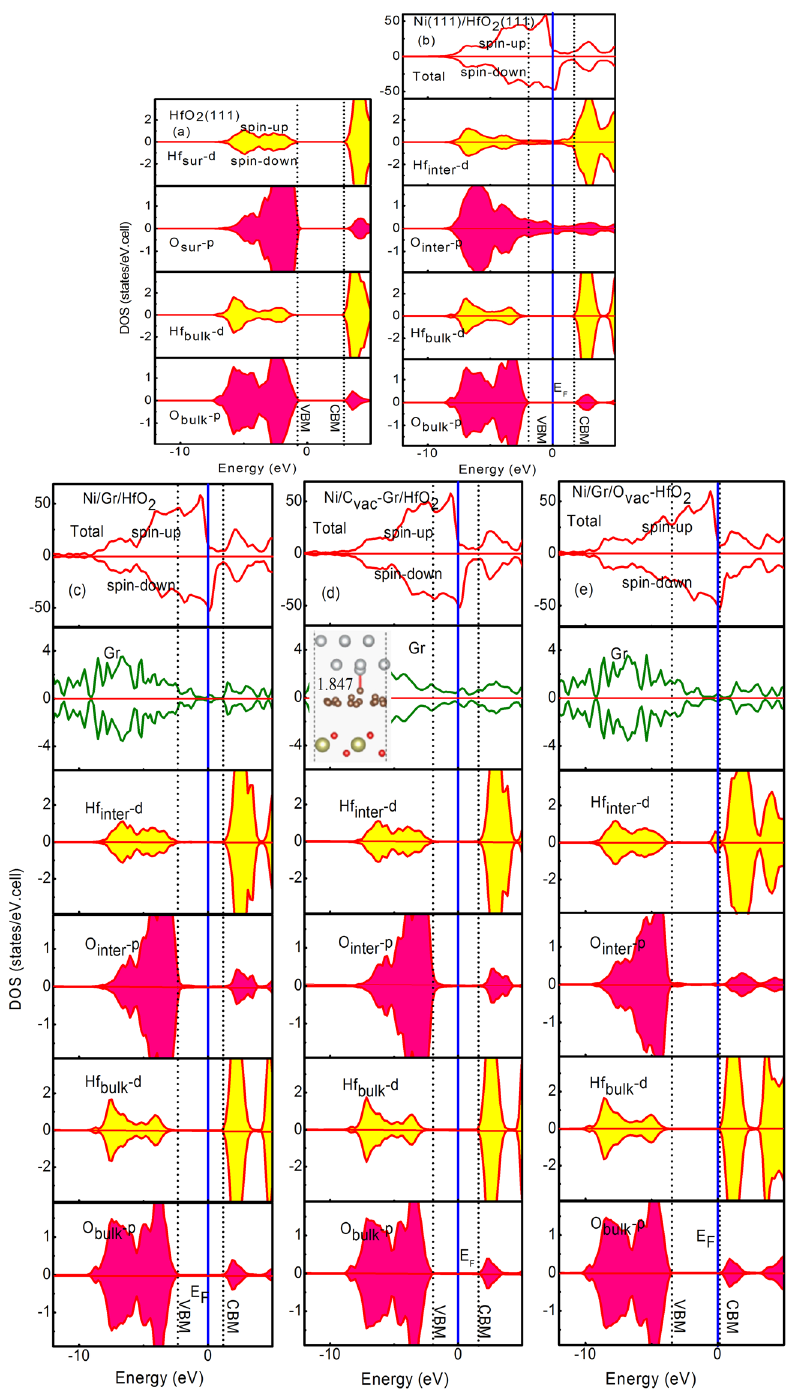
Figure 4. Total density of states (tDOS) and orbital-resolved partial density of states (PDOS) for ( a ) HfO 2 (111), ( b ) Ni(111)/HfO 2 (111), ( c ) Ni(111)/Gr/HfO 2 (111), ( d ) Ni(111)/C vac -Gr/HfO 2 (111), ( e ) Ni(111)/Gr/O vac - HfO 2 (111) interfaces. In the PDOS, the symbols are defined as follows: O and Hf in bulk region (O bulk , Hf bulk ), interface O and Hf (O inter , Hf inter ). The solid, dash, dot and dash lines denote Fermi energy of interface, VBM and CBM of HfO 2 ,